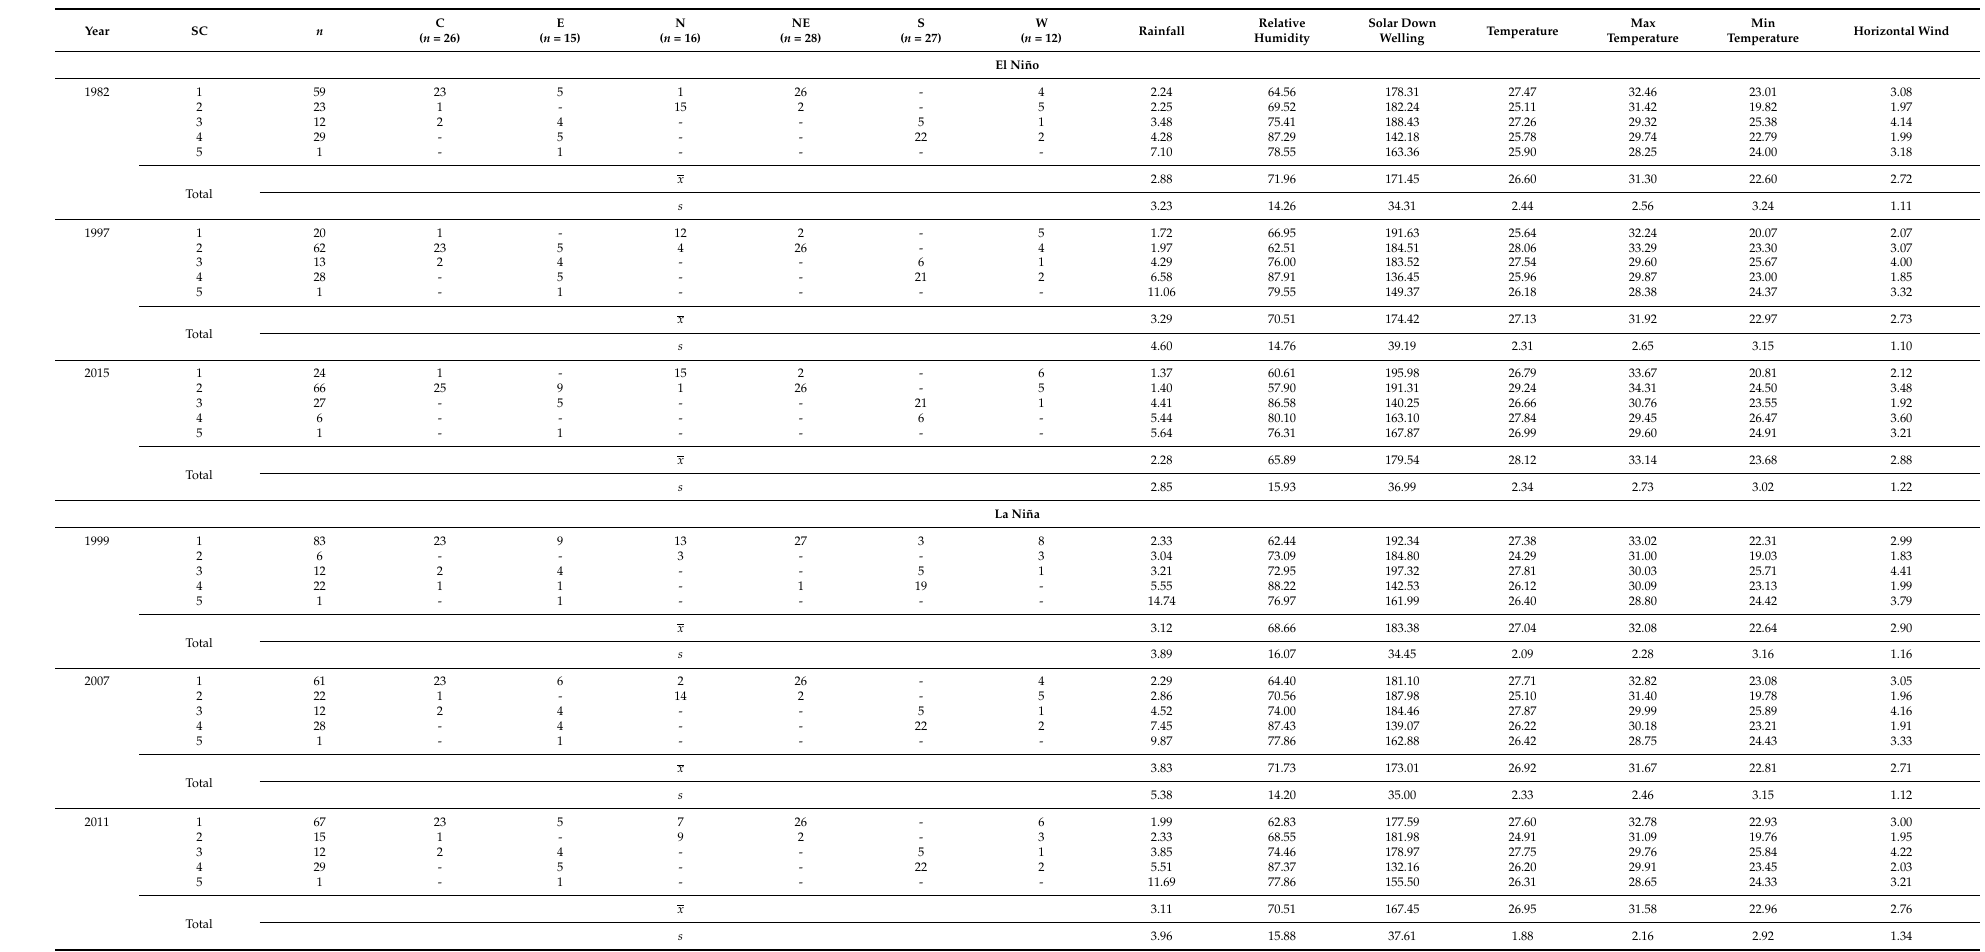
Table 3. Number of members and mean of monthly climate factors by ENSO events, years and